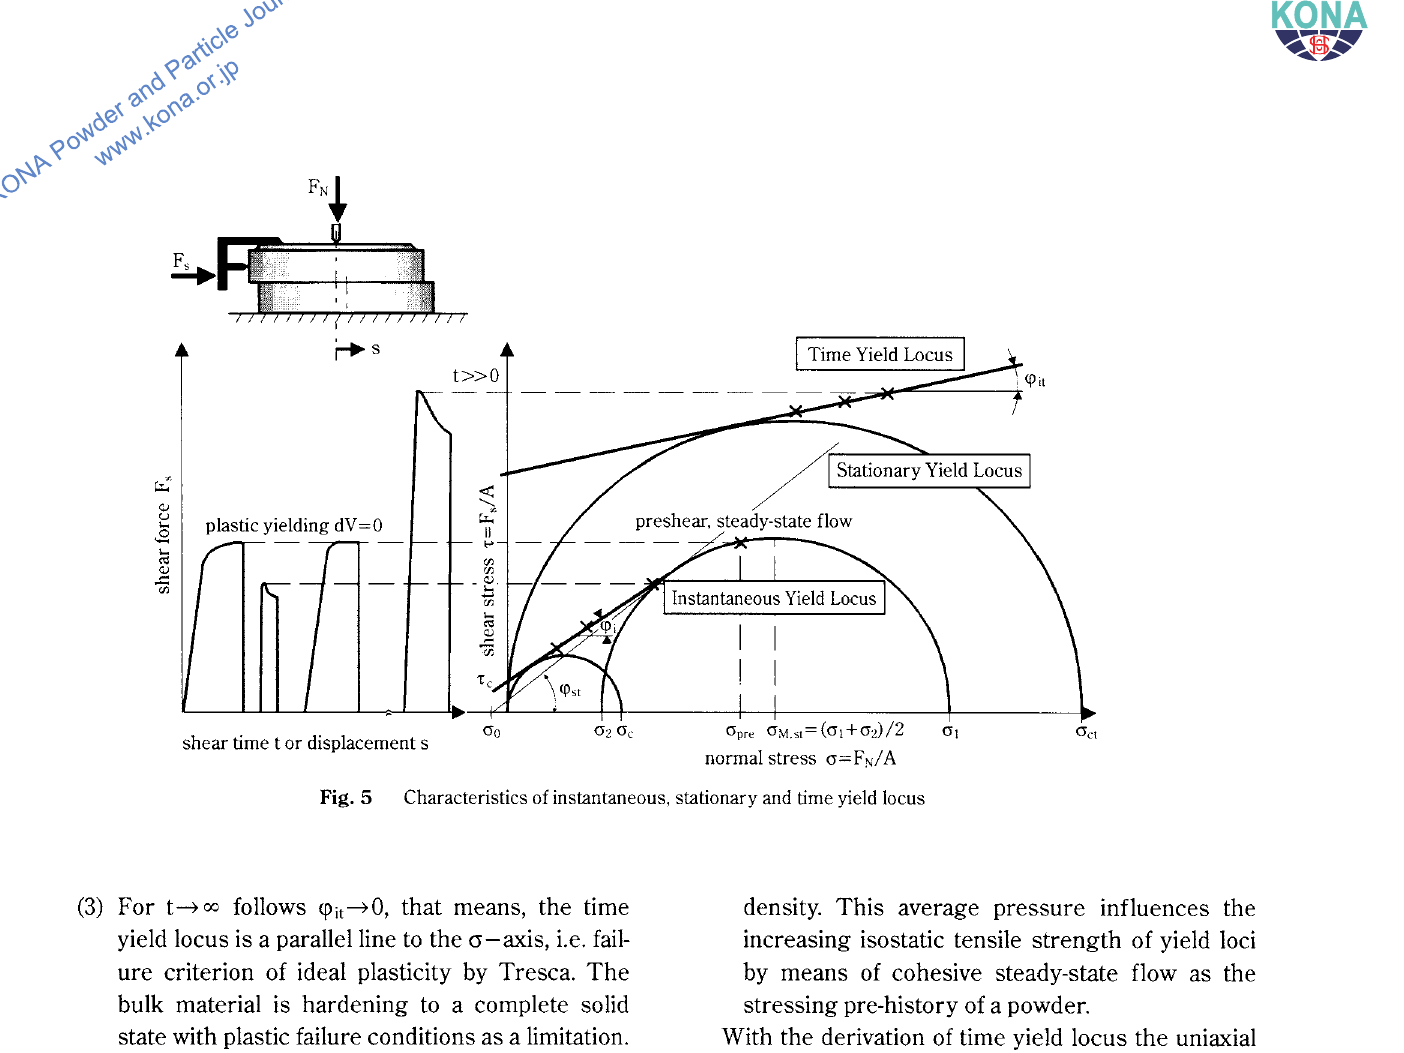
increasing isostatic tensile strength of yield loci by means of cohesive steady-state flow as the stressing pre-history of a powder. With the derivation of time yield locus the uniaxial compressive strength (unconfined yield strength) cret is found as function of the major principal stress cr1 comparable with a linear bulk material